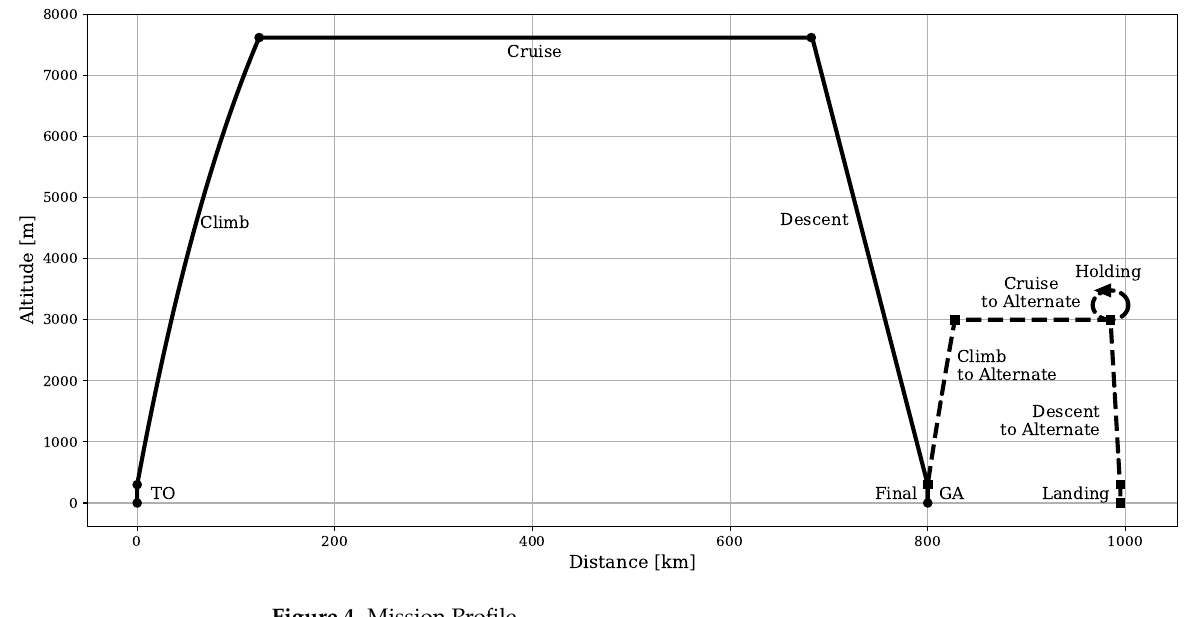
Figure 4. Mission Profile.